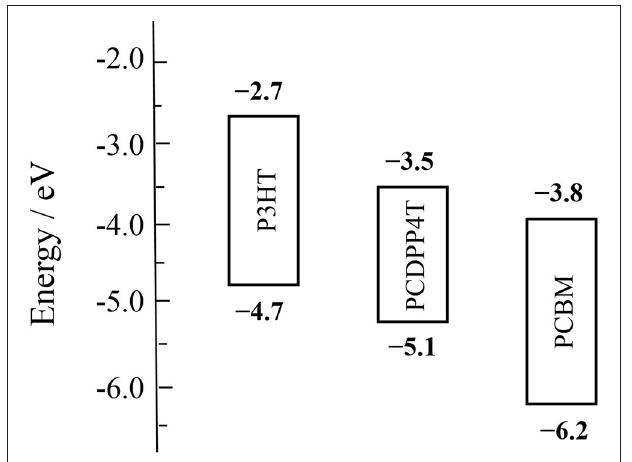
FIGURE 4 | HOMO and LUMO energy levels of materials employed in this study: P3HT, PCBM, and PCDPP4T. for the efficient charge transfer at the interfaces of P3HT/PCBM, PCDPP4T/PCBM, and P3HT/PCDPP4T.